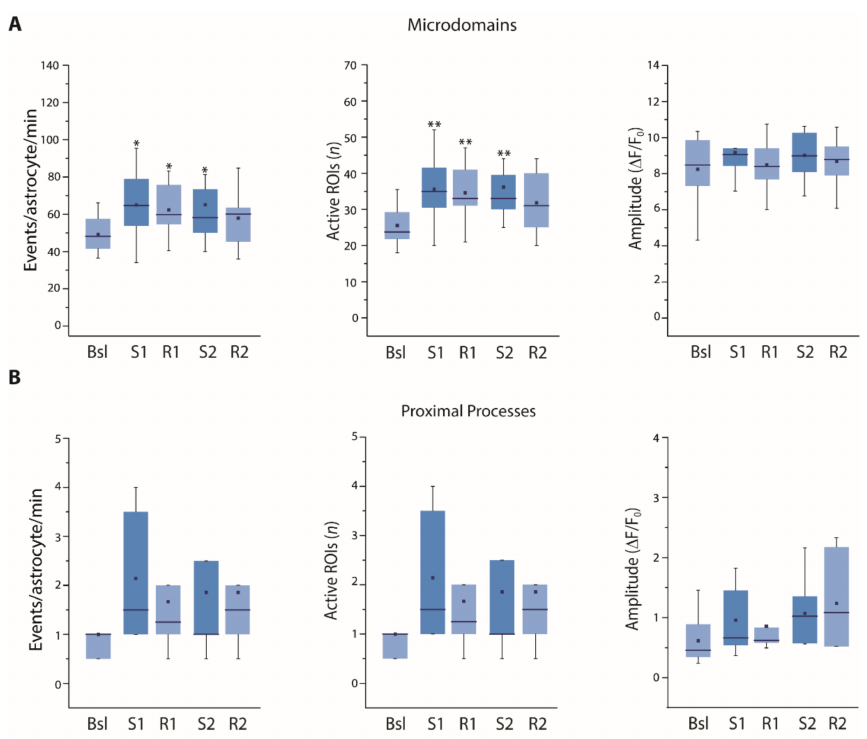
Figure 12. Astrocyte Ca 2+ response to STT interneuron stimulation is highly preserved when A 1 Rs are blocked. ( A , B ) Microdomains (8350 total events) and proximal process (130 total events) Ca 2+ responses to an intense stimulation of SST interneurons are highly preserved in the presence of the A 1 R antagonist DPCPX (12–7 astrocytes, respectively, 5 slices, 4 mice). * p < 0.05, ** p < 0.01, One-way repeated measures ANOVA with a post hoc Holm-Sidak test was used to compare all other conditions to Bsl condition.